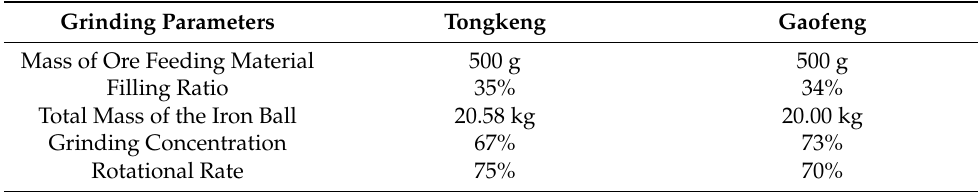
Table 3. The grinding parameters for Tongkeng ore and Gaofeng